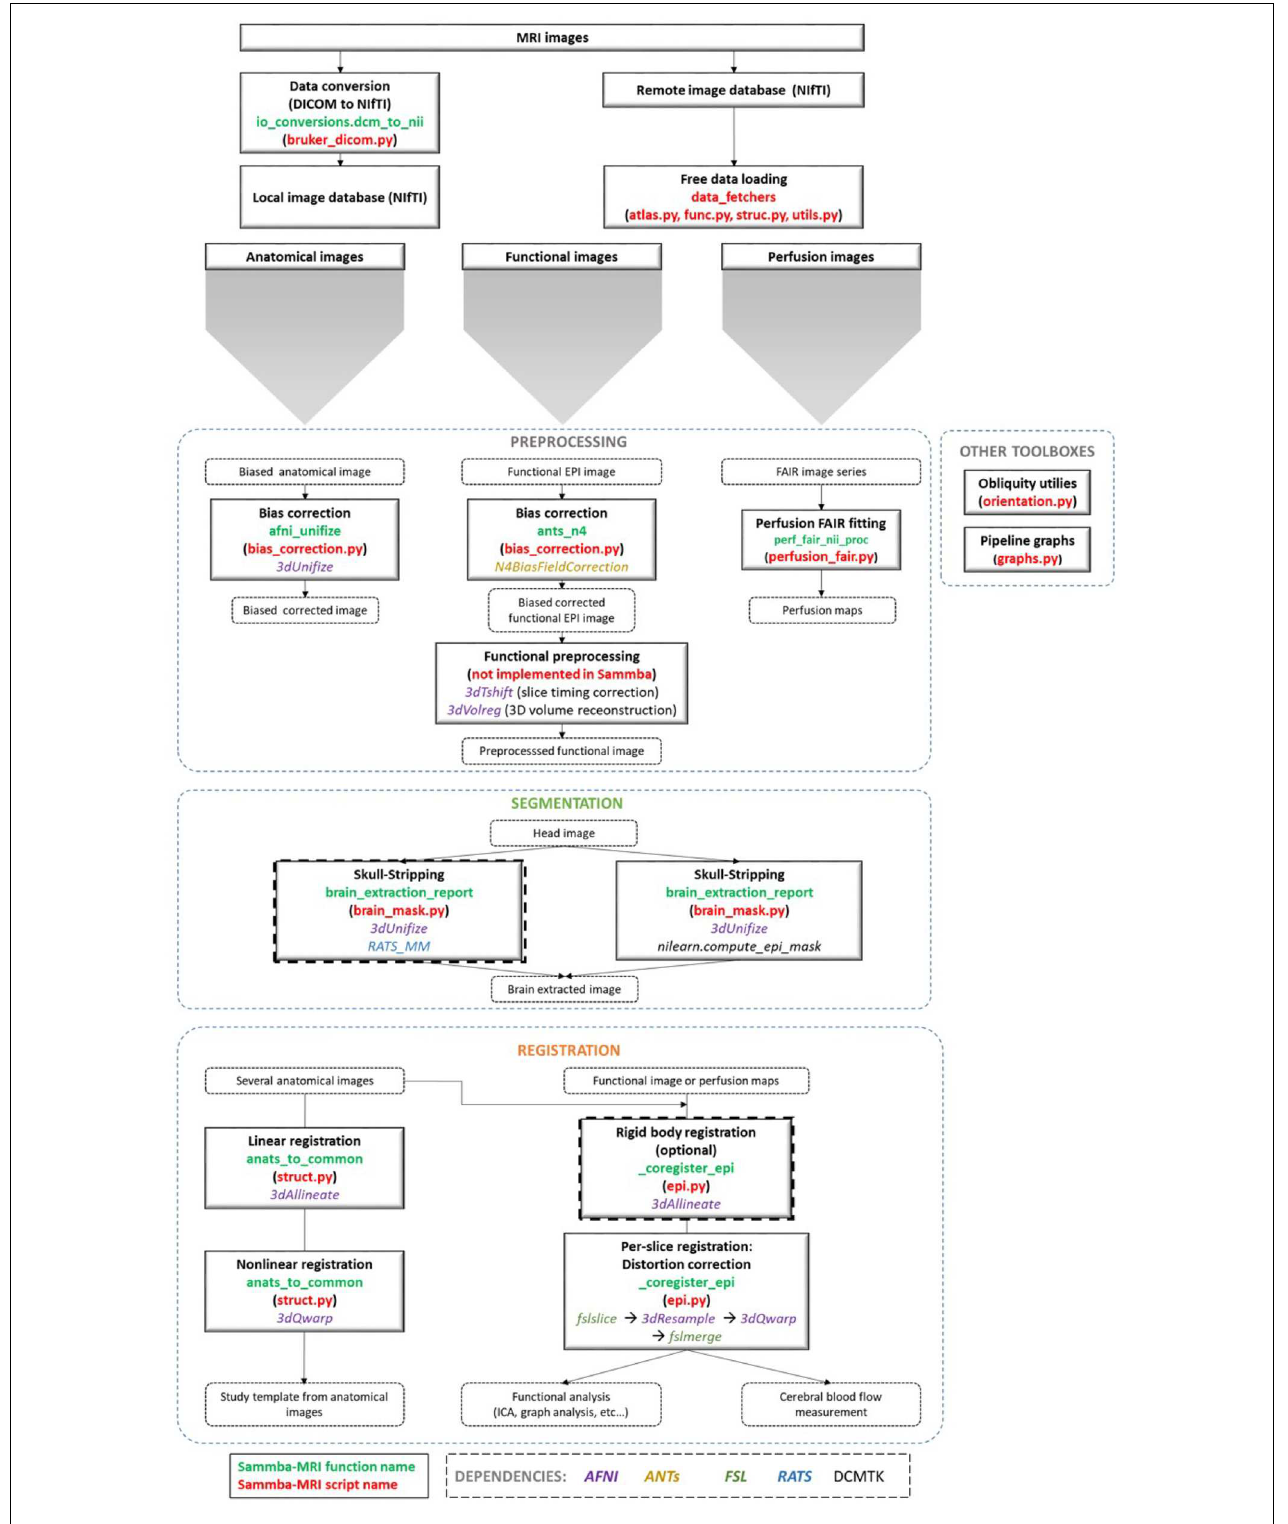
FIGURE 1 | Sammba-MRI workflow. Anatomical, functional, or perfusion images are imported from MRI local scanners or databases. They are analyzed using different preprocessing, segmentation and registration modules. Each function (green) and python-scripts (red) of Sammba-MRI are presented. Library dependencies are specified with color